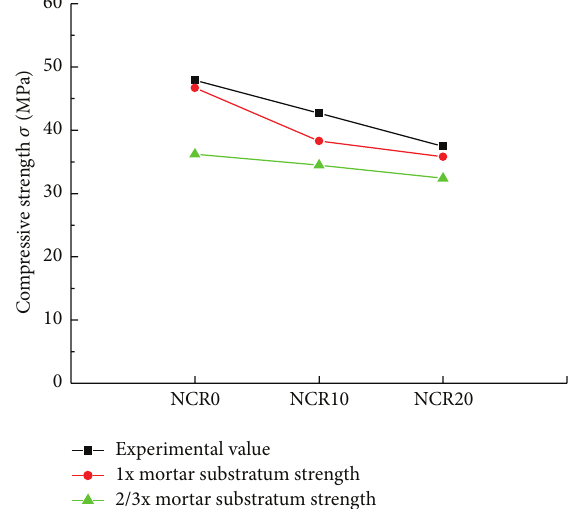
Figure 8: Comparison of various computational and experimental